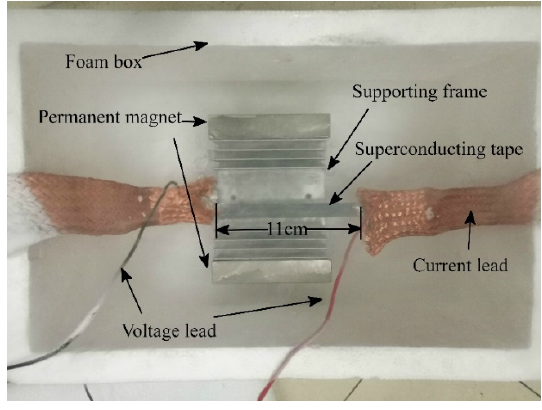
Figure 3. Experiment objective .